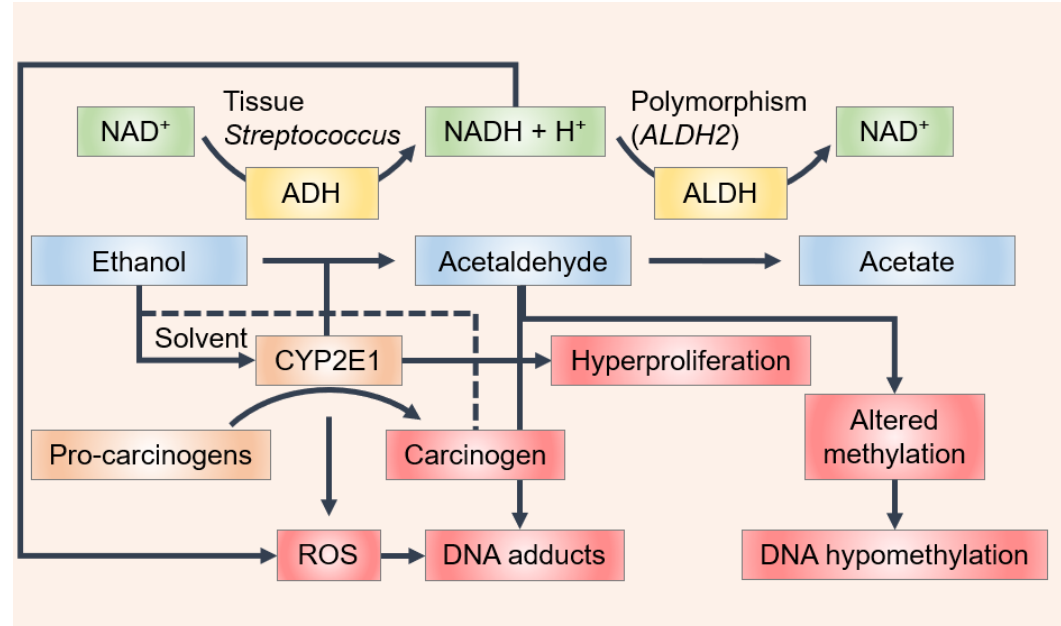
Figure 1. Scheme of the mechanisms by which ethanol may affect oral carcinogenesis. Ethanol is metabolized to form acetaldehyde by alcohol dehydrogenase (ADH) and cytochrome P450 2E1 (CYP2E1) in the oral cavity and is further oxidized to form acetate by acetaldehyde dehydrogenase (ALDH). ADH-mediated ethanol metabolism results in the generation of reducing equivalents in the form of reduced nicotinamide adenine dinucleotide (NADH) and acetaldehyde, whereas ethanol oxidation by CYP2E1 leads to the production of acetaldehyde but also to the generation of reactive oxygen species (ROS). Single nucleotide polymorphisms of ALDH2 cause the production and/or oxidation of acetaldehyde to vary between individuals. Increased CYP2E1 activity not only leads to an increased generation of ROS but also leads to an increased activation of various environmental agents such as the pro-carcinogens present in tobacco smoke. Ethanol may also act as a solvent for these carcinogens to enter the cell. Acetaldehyde can bind to DNA, forming stable adducts, and ROS results in lipid peroxidation products, such as 4-hydroxynonenal (4-HNE), which bind to DNA to form mutagenic adducts. During cancer promotion, ethanol and acetaldehyde alter methyl transfer, leading to DNA hypomethylation that could change the expression of oncogenes and tumor-suppressor genes. Finally, ethanol-associated immune suppression may facilitate tumor cell spreading.